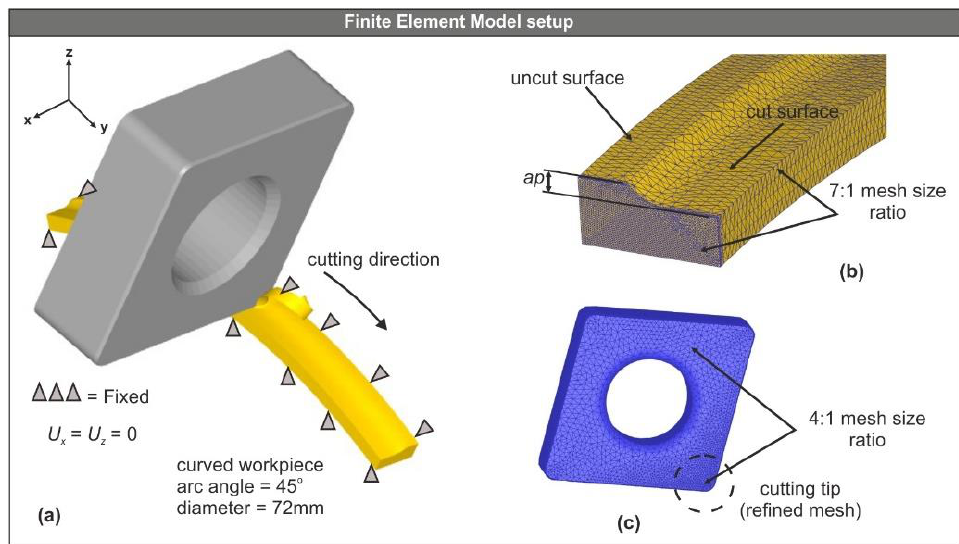
Figure 8. The model setup ( a ), the analysis domain ( b ) and the meshed tool ( c ).